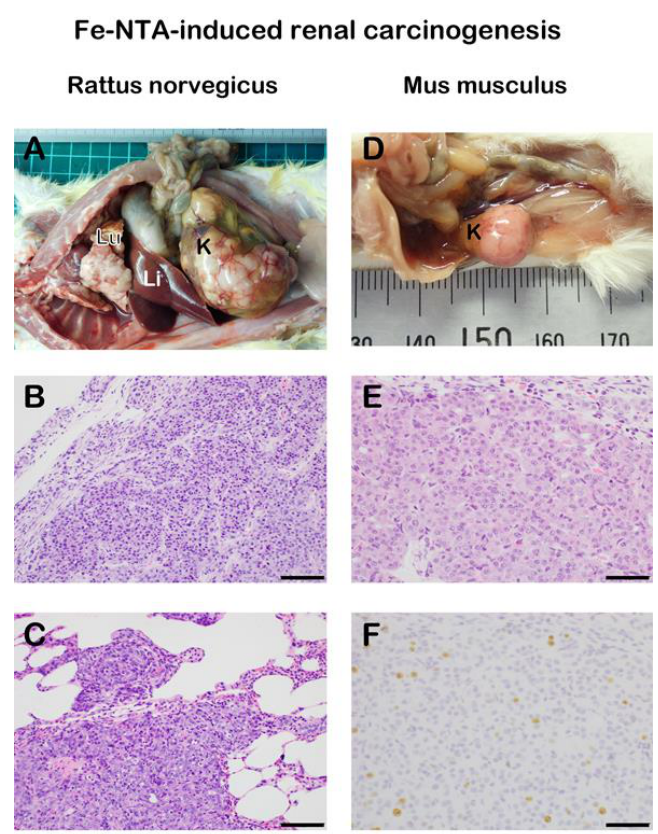
Figure 3. Species differences in ferric nitrilotriacetate (Fe-NTA)-induced renal carcinogenesis in wild-type rodents. Induction of an advanced renal cell carcinoma (RCC) with extensive pulmonary metastasis is frequently observed in rats whereas smaller RCC without metastasis is obtained with a much lower incidence in mice. ( A ) Macroscopic view of RCC with pulmonary metastasis and invasion in a male wild-type Sprague-Dawley rat 1 y after 11 weeks of repeated intraperitoneal 5–10 mg iron/kg Fe-NTA administration (3–5 times a week). Note primary RCC of 75 mm in diameter in the kidney and many metastatic nodules of 1–2 mm on the surface of lung. K, kidney. Li, liver. Lu, lung. ( B ) Histology of the primary RCC in the kidney. Proliferation of atypical glandular cells are observed in irregular glandular or solid structure (Hematoxylin and eosin staining). ( C ) Histology of the metastatic RCC in the lung. Similar adenocarcinoma to the primary site is invading the pulmonary alveolar structure. ( D ) Macroscopic view of RCC in a male wild-type A / J mouse 10 months after 12 weeks of repeated intraperitoneal 5–7 mg iron / kg Fe-NTA administration (6 times a week). Dose di ff erence in the protocol between rats and mice comes from the di ff erence in sensitivity to Fe-NTA. K, kidney. ( E ) Histology of the primary RCC in the kidney. Proliferation of atypical glandular cells are observed in irregular glandular or solid structure. ( F ) Ki-67 immunostaining of the RCC with an index of 5% (bar = 100 µ m in B and C, 50 µ m in E and F).